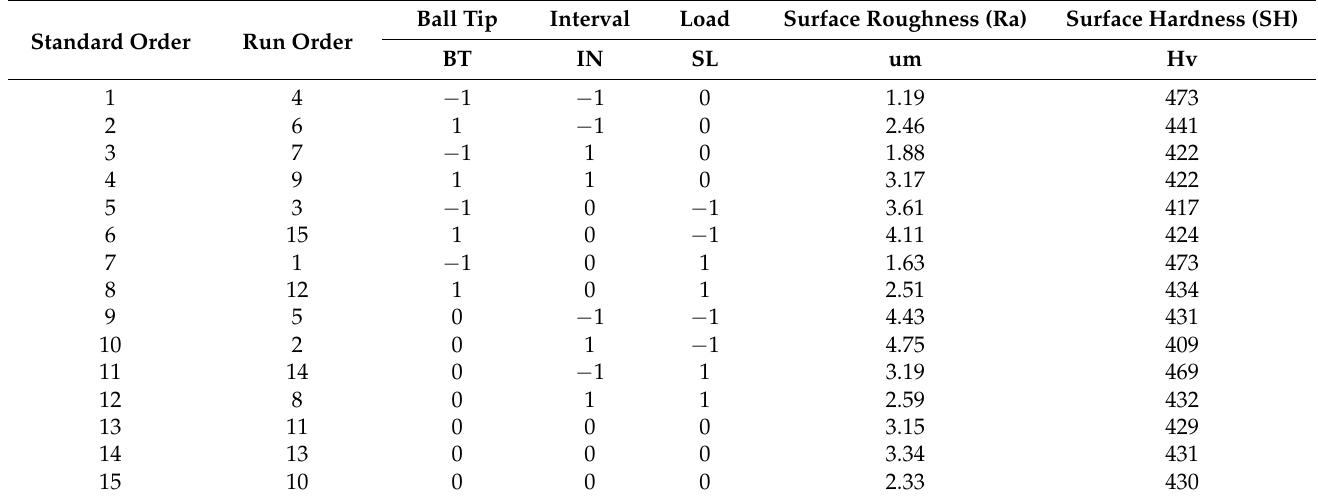
Table 4. Response values of each specimen treated according to design of experiment.